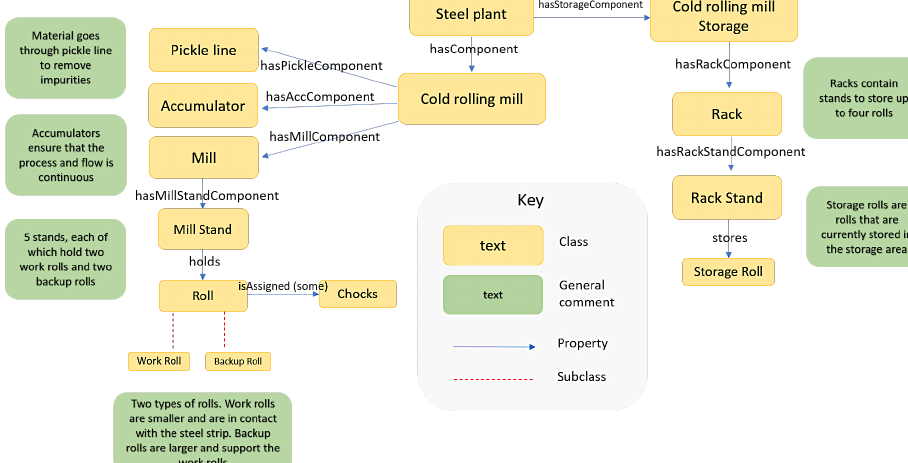
Figure 1. Structure of SCRO.